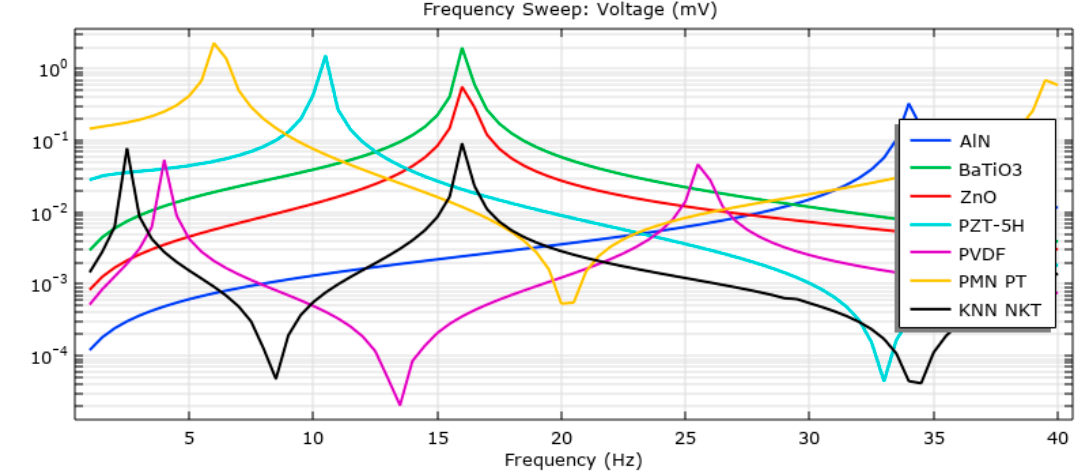
Figure 3. The transverse vibration response of the thin-film energy harvesters: voltage output. A peak power output of 1.1 × 10 − 6 , 2.6 × 10 − 6 , and 1.8 × 10 − 6 µ W was observed in PZT, PMN-PT, and BaTiO 3 , respectively, which rendered them unusable in the form of an energy harvester at such dimensions. The output performance of these structures was plotted on a similar log-scale for comparison in Figure 4. The poor output performance of the thin-film strip was attributed to the low-charge density in the sample due to its small size. It is interesting to note that the single layer thin-films, though fascinating, failed to generate a usable amount of energy and required one to resort to a compounded structure.